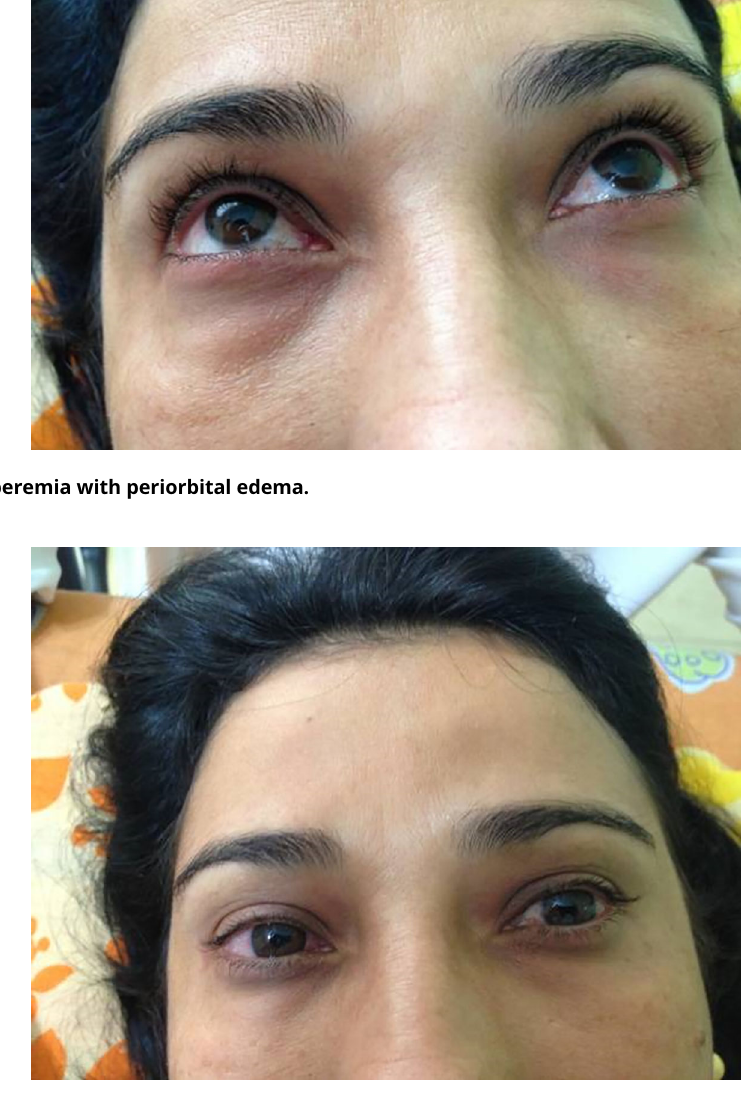
Figure 1B. After cervical lymphatic